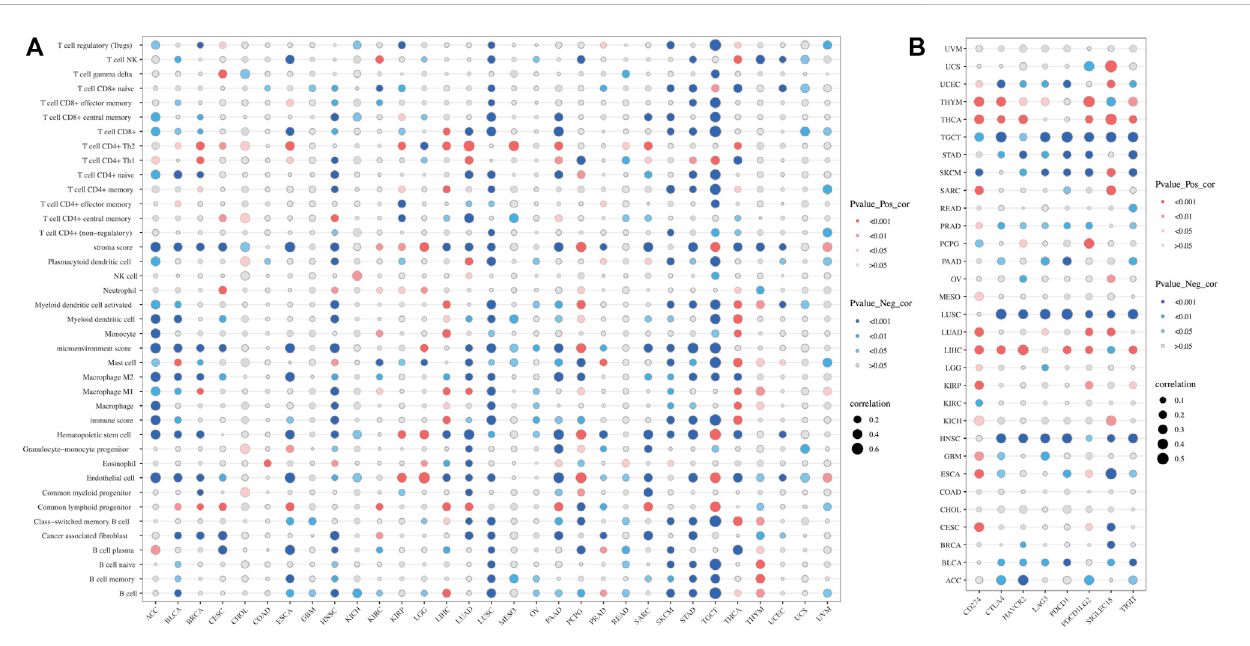
FIGURE 8 Correlation of SLC2A1 expression with (A) immune in fi ltrating cells in pan-cancer by CIBERSORT algorithm (B) Immune checkpoint genes, including CD274, CTLA4, HAVCR2, LAG3, PDCD1, PDCD1LG2, SIGLEC15, and TIGIT. Red indicated a positive correlation and blue indicated a negative correlation, and the size of the bubble indicates the magnitude of the